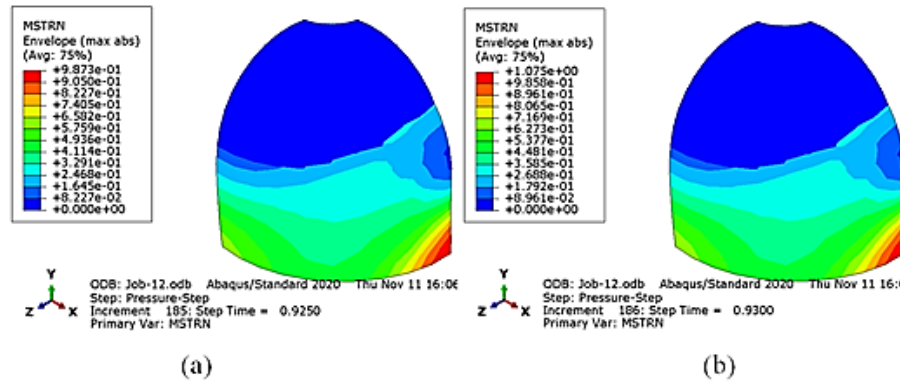
Figure 8. Maximum strain failure index: ( a ) at load step 0.925 and ( b ) at load step 0.93.